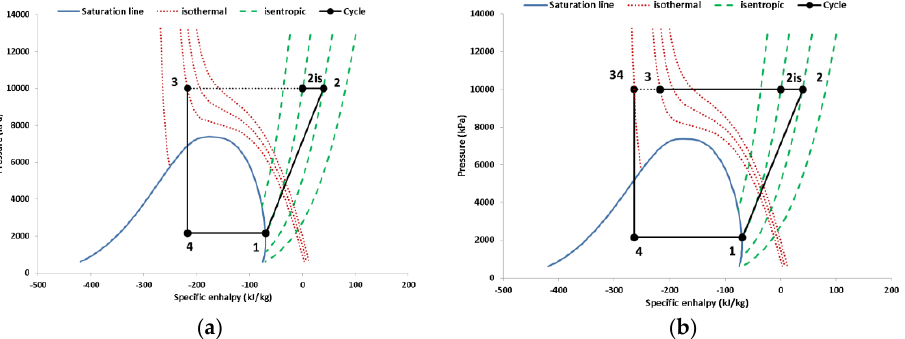
Figure 4. Pressure-specific enthalpy diagrams: ( a ) for the reference system, and ( b ) for the systems with dedicated subcooling.